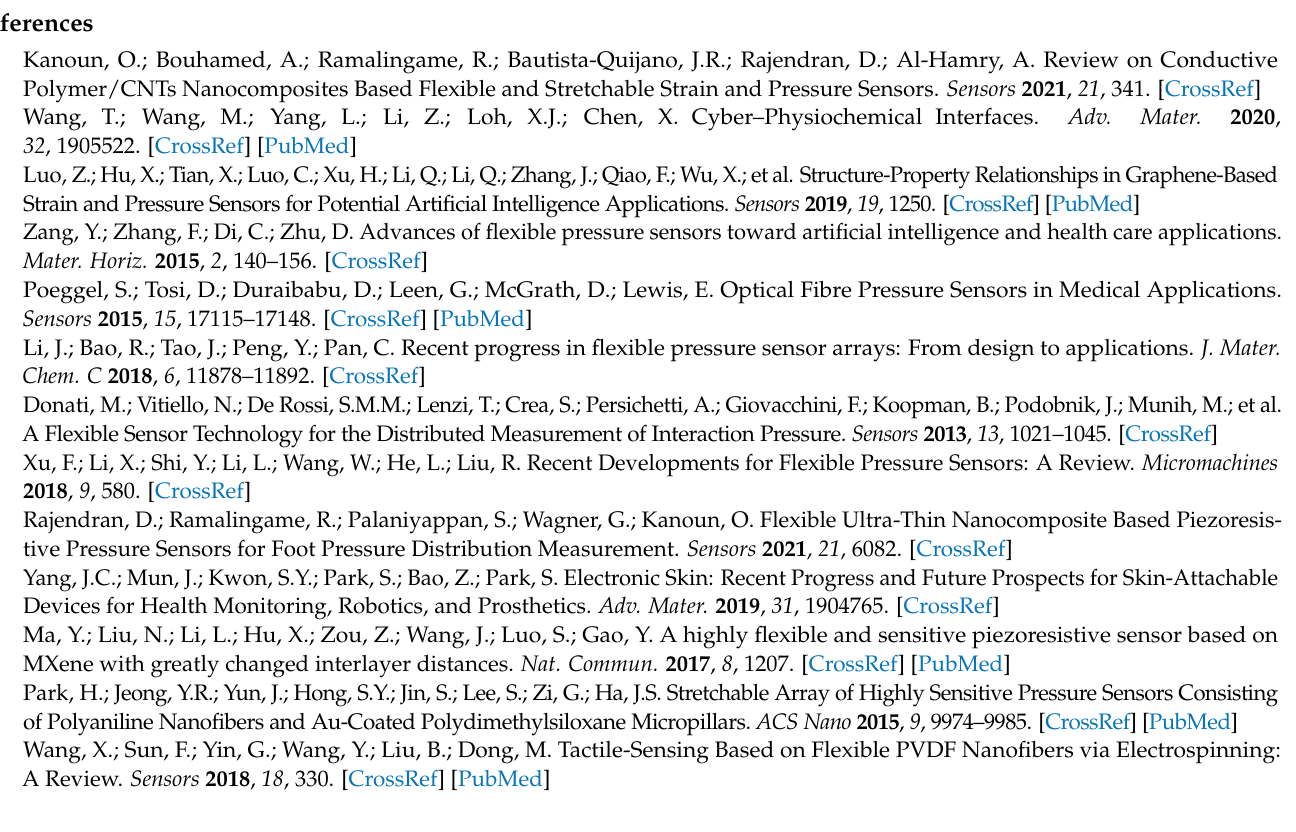
Figure S1: Schematics showing the structural variations of the sandwich electrode configuration and the side-by-side electrode configuration under externally applied pressure.; Figure S2: The extracted heart rates from the original pulse signals at different physiological statuses.; Figure S3: Digital picture showing the electronic skin with 16 sensors, along with the size